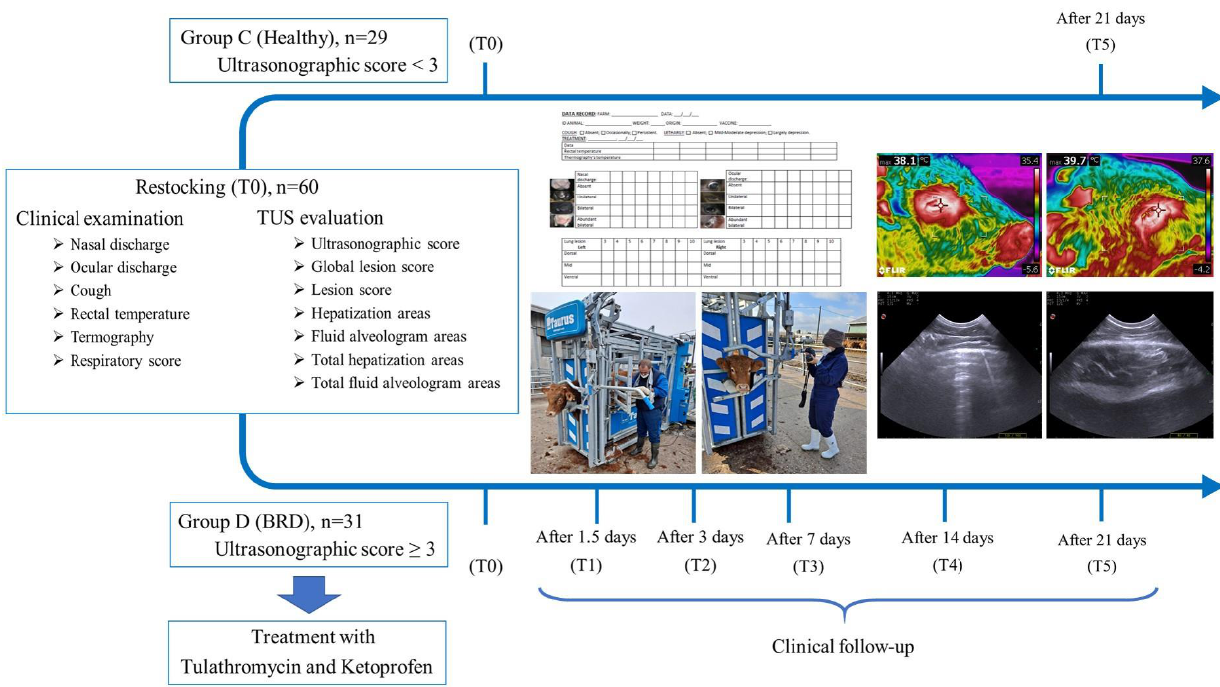
Figure 1. Experimental design flowchart of the study.